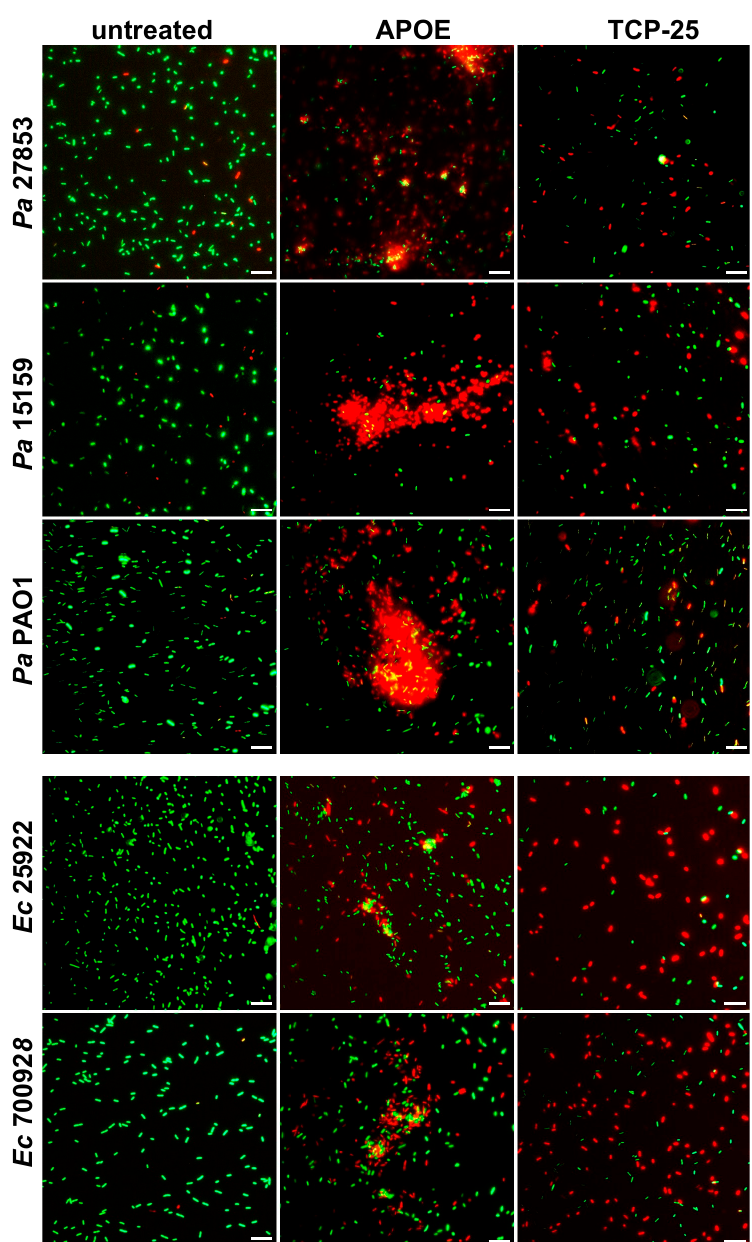
Figure 2. Visualization of E. coli and P. aeruginosa viability. Live/Dead Viability Assay of Gram- negative bacteria stimulated with 2 μ M APOE, 10 mM Tris buffer at pH 7.4 (negative control) or 2 µ M TCP-25 (positive control). Representative images from three independent experiments are presented (n = 4). At least ten individual fields were acquired per experiment. Live bacteria were stained with green SYTO 9 nucleic acid fluorescent dye, and dead bacteria were stained using red propidium iodine dye. Scale bar represents 5 μ m.